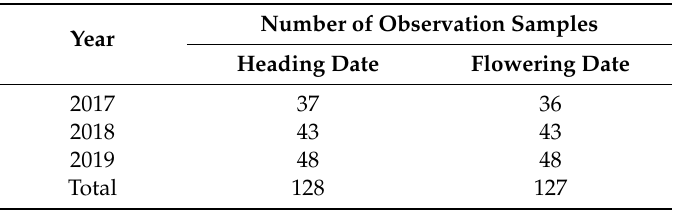
Table 1. Number of available observation